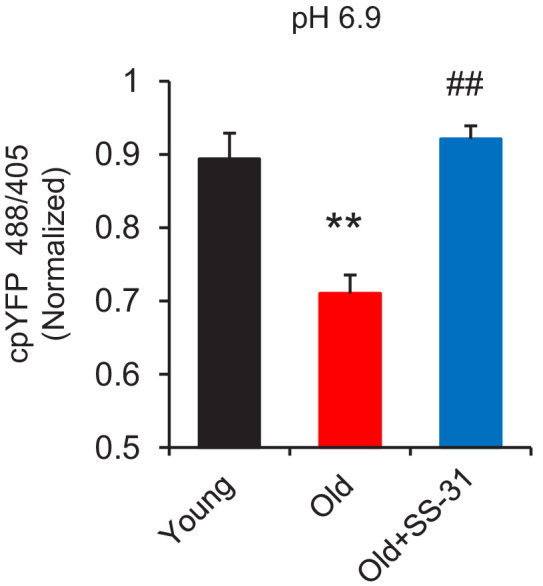
SS31 restores the resistance to external pH gradient stress in the old cardiomyocytes at pH 6.9.N = 5–18 in each group. One-way ANOVA with Dunnett’s test was applied. **p<0.01 vs young, #p<0.05 vs old controls.